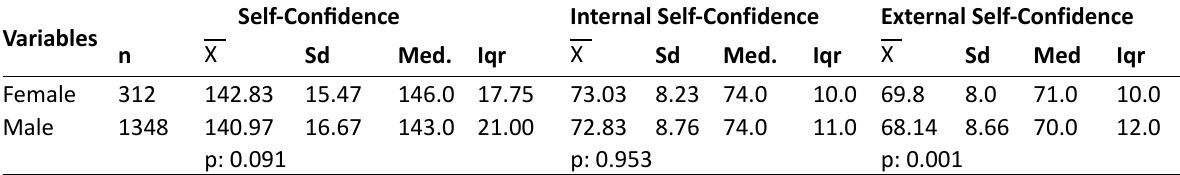
Table 2. Comparison of self-confidence and sub-dimensions according to athletes’ genders Variables